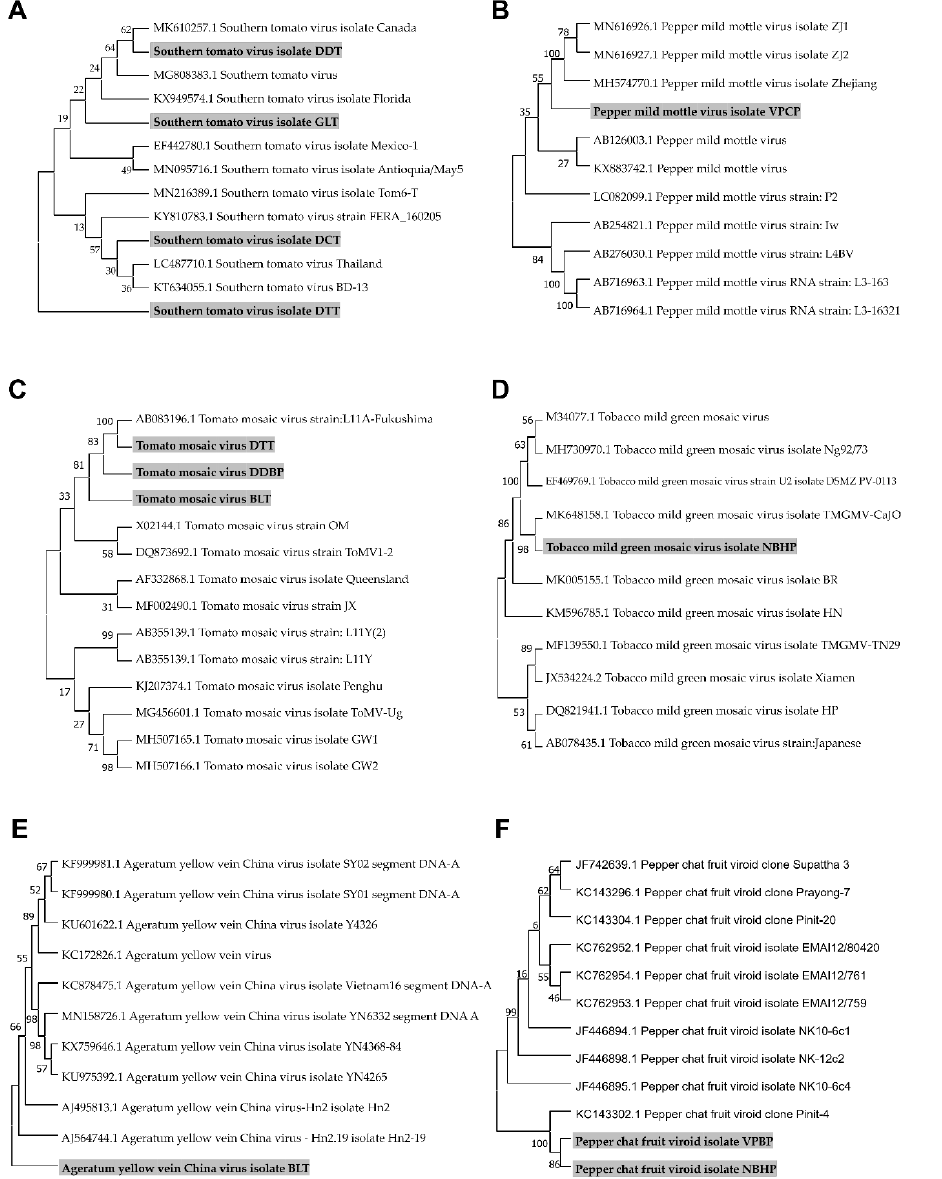
Figure 6. Phylogenetic trees for the identified five viruses and a viroid. For the construction of phylogenetic trees, we selected five viruses, including STV ( A ), PMMoV ( B ), ToMV ( C ), TMGMV ( D ), and AYVCNV ( E ), and a viroid PCFVd ( F ), in which genome sequences were assembled by RNA-Seq. Assembled viral genome sequences, as well as matched known viral genome sequences from GenBank, were subjected to the construction of phylogenetic trees. Phylogenetic trees were constructed using the MEGA7 program using the Maximum Likelihood method with a bootstrap of 1000 replicates. The identified viral isolates from this study were marked by the gray